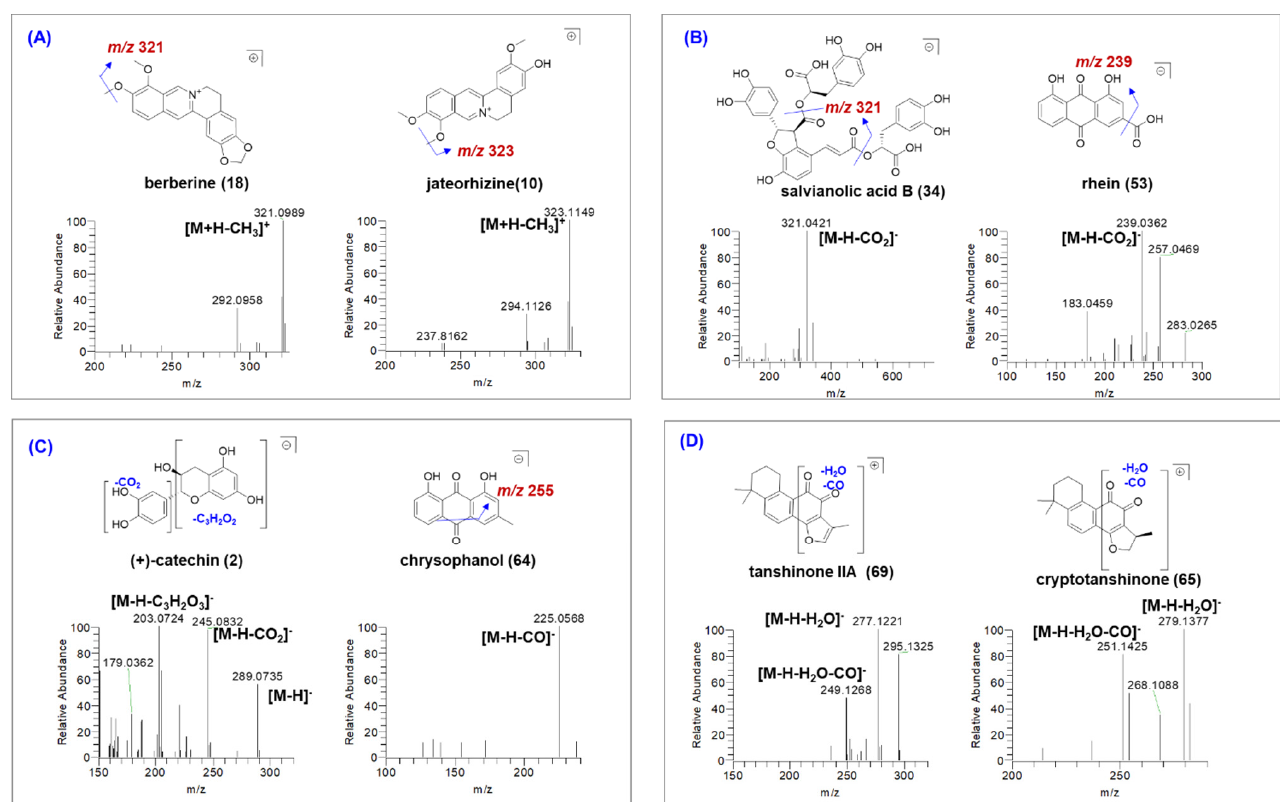
Figure 2. The MS/MS spectra of representative compounds identified in GDL Pill. ( A ) for alkaloids, ( B ) for organic acids, ( C ) for phenolic compounds, and ( D ) for tanshinones.